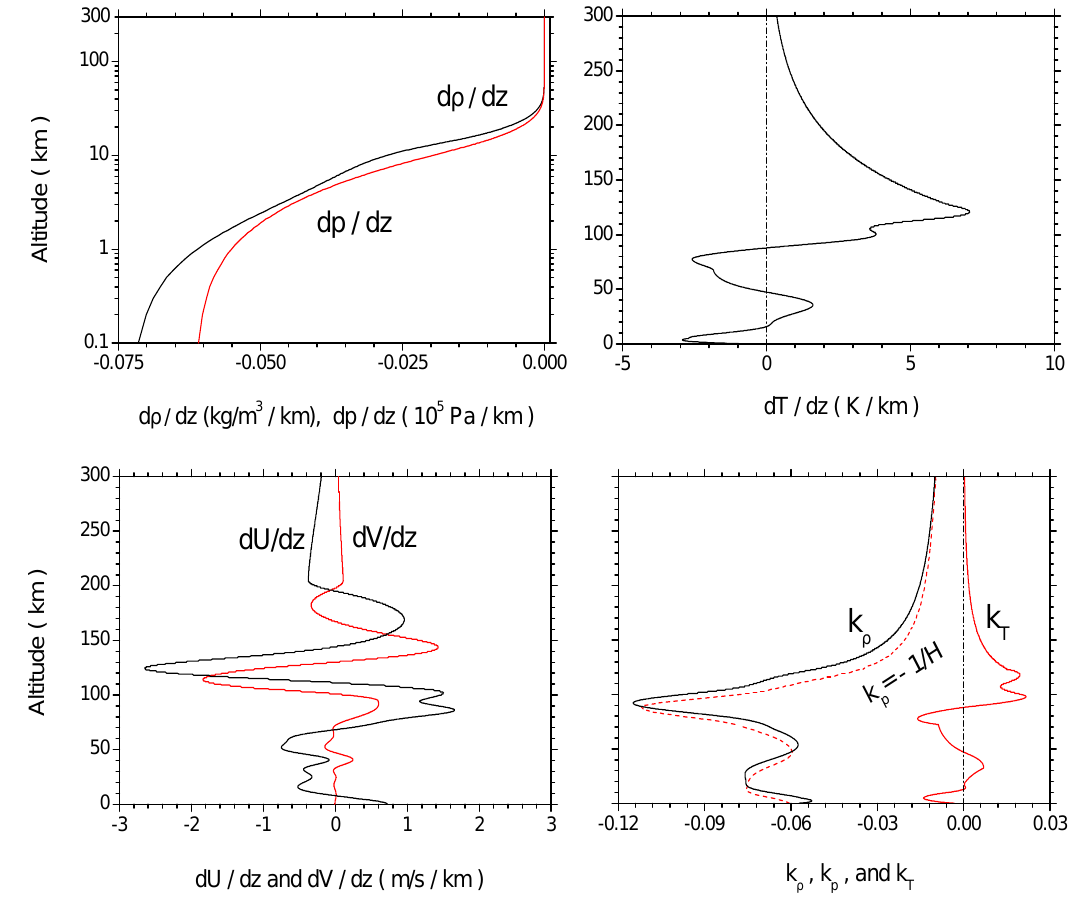
Figure 2 discloses the properties of atmospheric inhomogeneities versus height calculated from the vertical profiles of the mean-field density, pressure, temperature and horizontal wind components in Figure 1. The upper left panel portrays density gradient d ρ 0 /d z and pressure gradient d p 0 /d z . Definitely, the two curves show a d ρ 0 /d z (cid:54) = d p 0 /d z . This means the density scale height is not the same as the pressure scale height (notice in Hines’ isothermal model that these two heights are the same as each other). However, they are merging together at higher altitudes and eventually united into one above a 200-km altitude, according to the calculated data. In addition, the two scale heights are not the same because the background temperature T 0 increases dramatically with z in the thermosphere. Once T 0 is constant with height ( z > 200 km, as shown in Figure 1), the density and pressure scale heights are equal [79]. In the upper right panel, temperature gradient d T 0 /d z transits twice from negative to positive below a 100-km altitude, within 10 m/s per km. Initiating from a 120-km altitude, it declines monotonously versus altitude, returning moderately to zero.